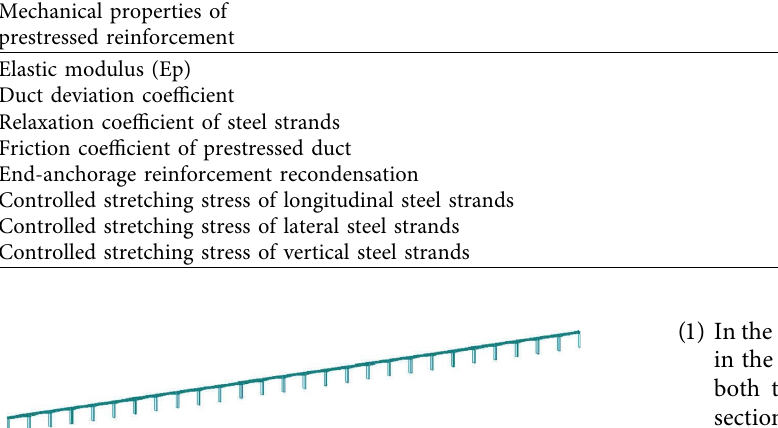
Figure 4: Nine-link 3 × 70m continuous rigid frame 3D fnite element model.